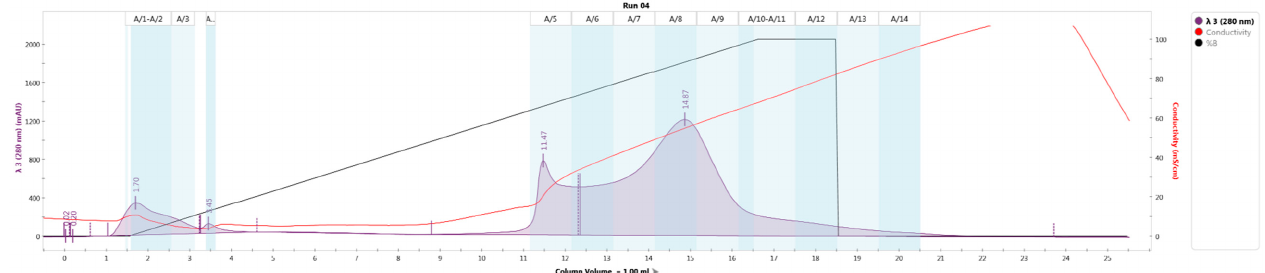
Figure 1. The identification of metabolites produced by selected microorganisms ( B. megaterium , P. fluorescens , P. putida , P. aeruginosa , P. oleovorans ).